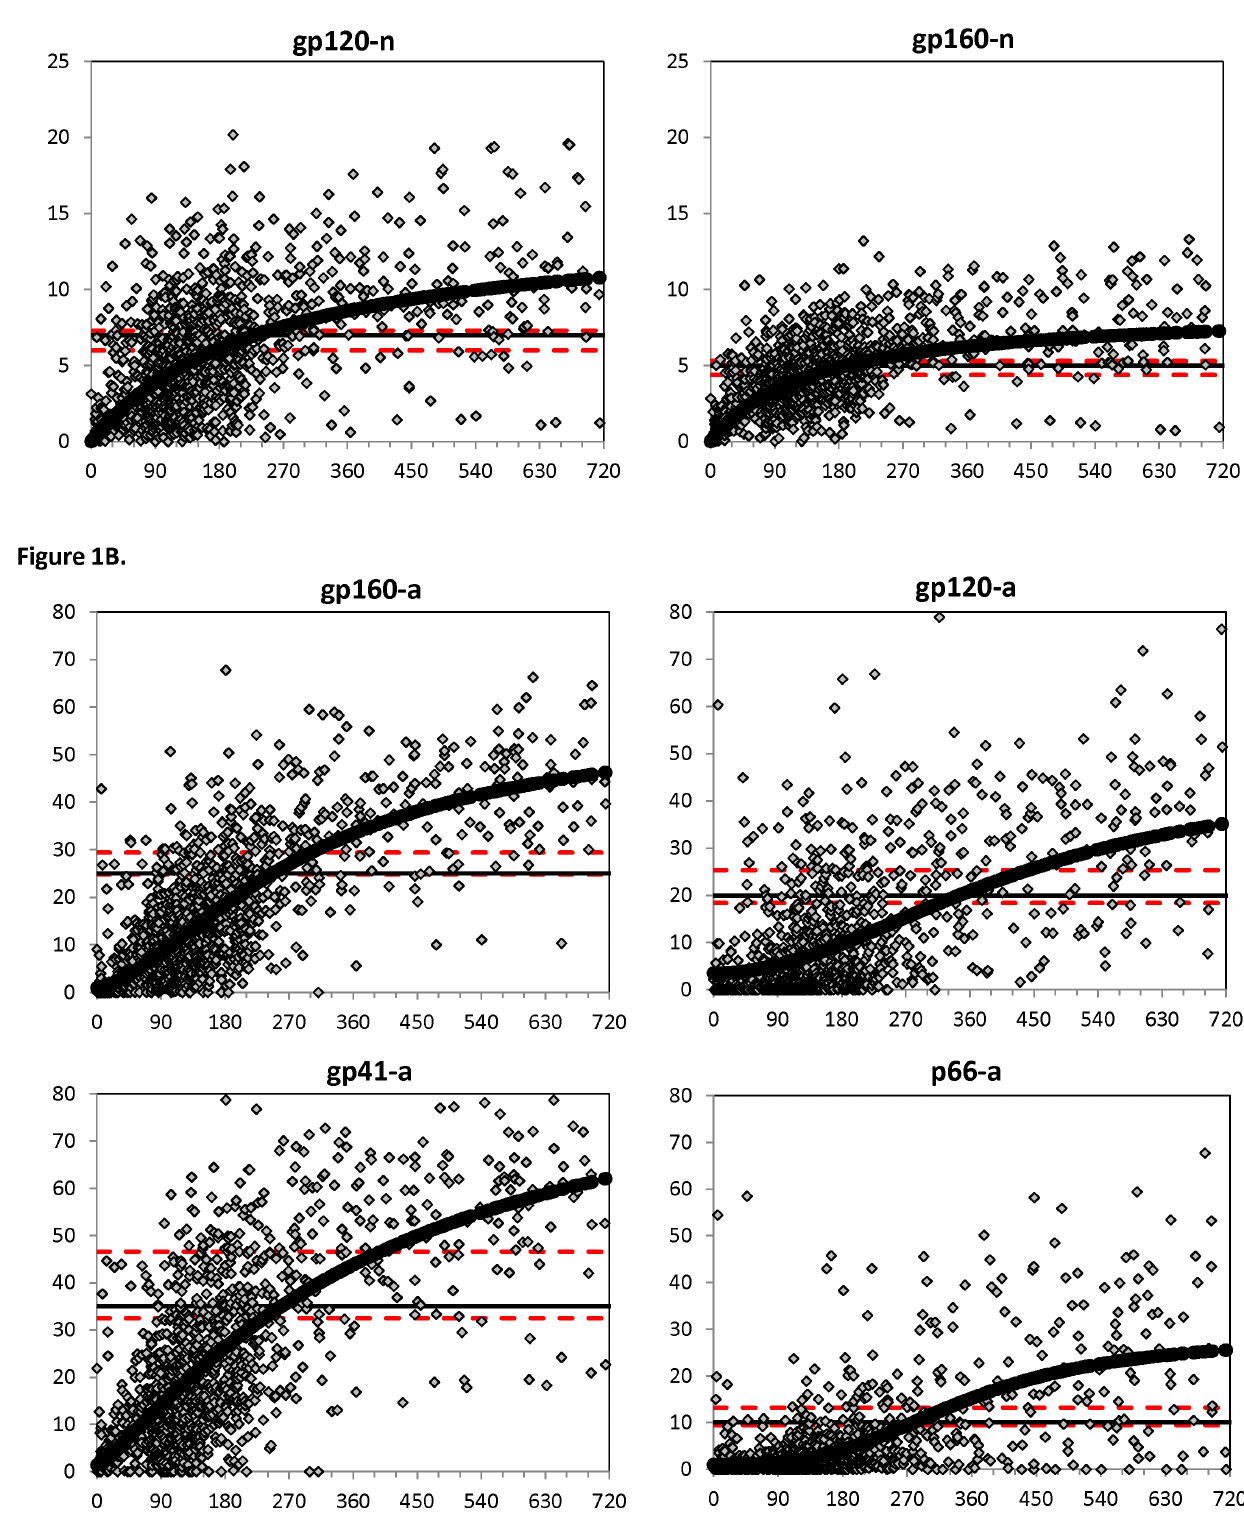
Figure 1. Longitudinal HIV-1-specific antibody responses. The normalized values (A) and avidity index (B), as measured by the Bio-Plex assay, for longitudinal seroconverters were plotted over days since seroconversion. Gray diamonds indicate individual data points and solid black circles represent the curve fit for each graph. Dashed red lines represent the half maximal response of the curve and lower 99.9% confidence limits of the estimate, while the solid black line represents the selected cutoff.